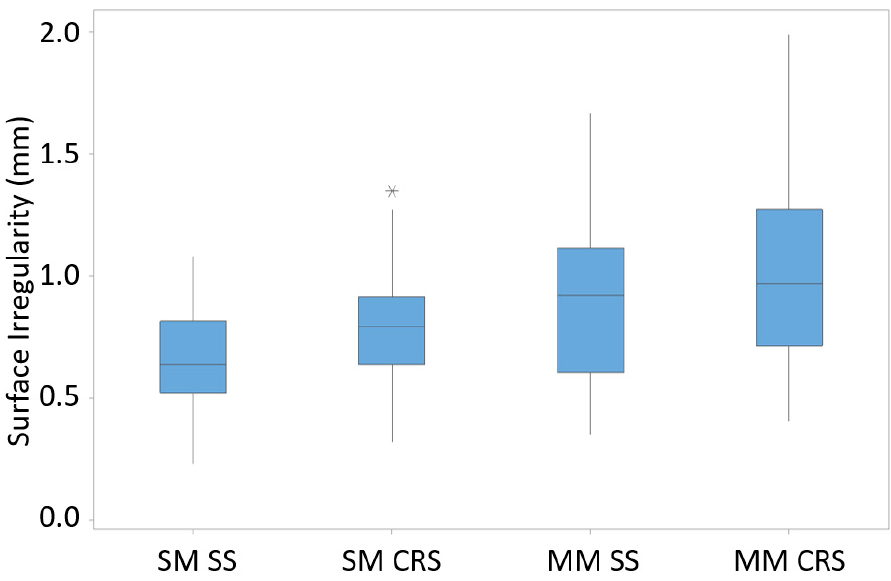
Figure 14. Surface irregularity for various components (SM: single ‐ material; MM: multi ‐ material).